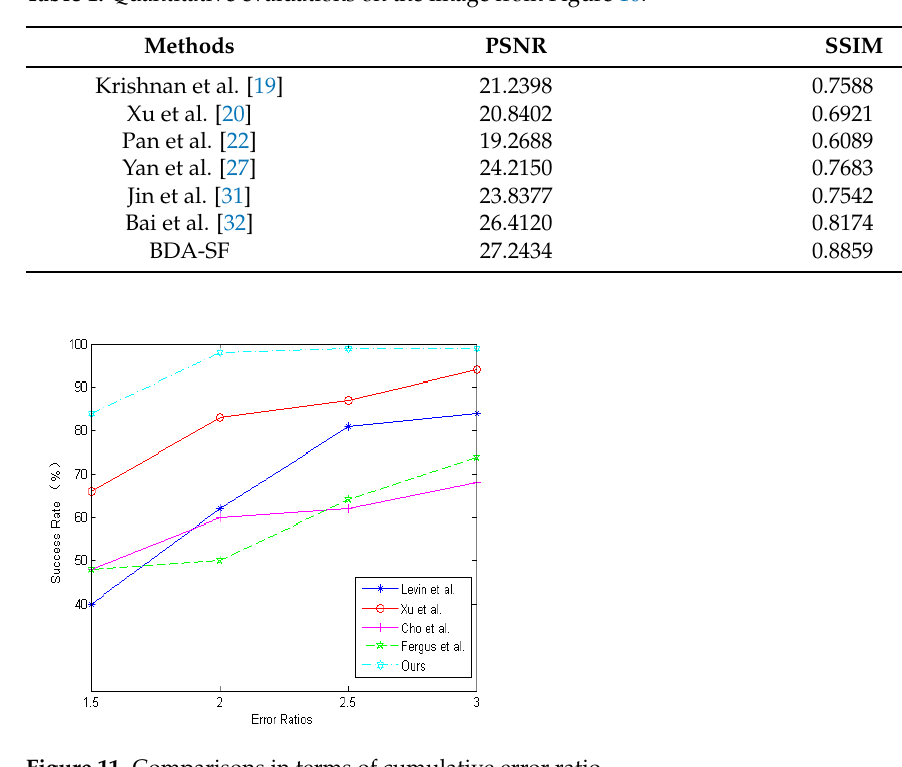
Figure 11. Comparisons in terms of cumulative error